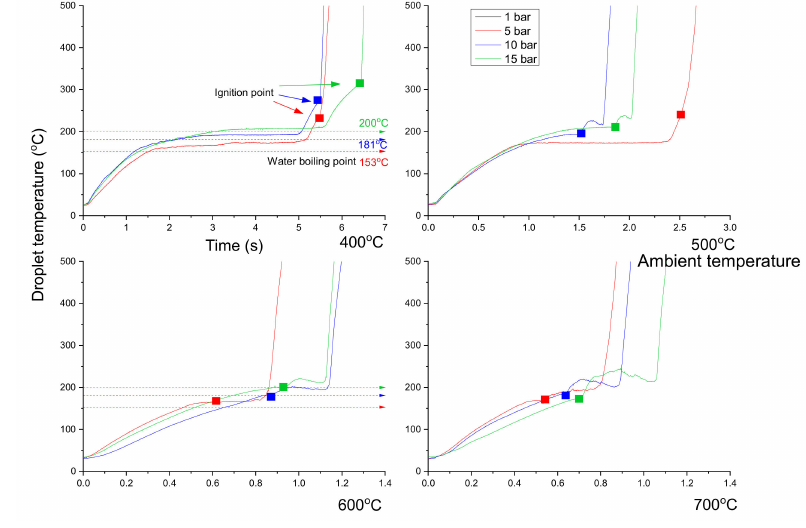
Figure 11. Temperature change in an emulsion droplet at various ambient temperatures and pressures.